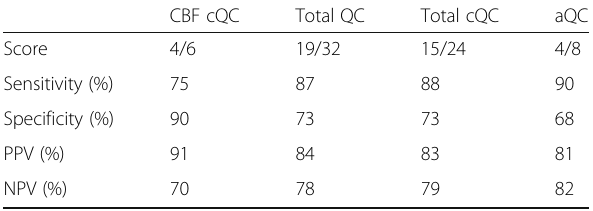
Table 4 Performance of CBF, QC, cQC, and aQC